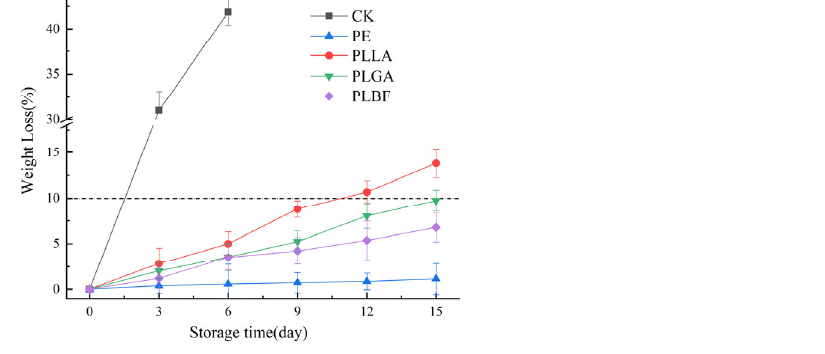
Figure 4. Changes in the weight of Agaricus bisporus in each packing group during